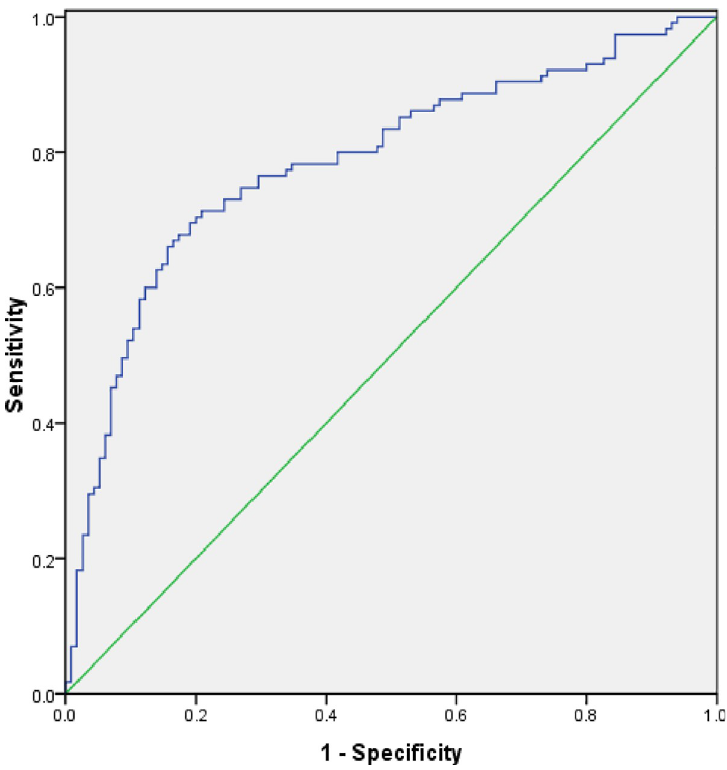
Fig 11. Receiver operator characteristic (ROC) curve based on testing data from March 20, 2020.